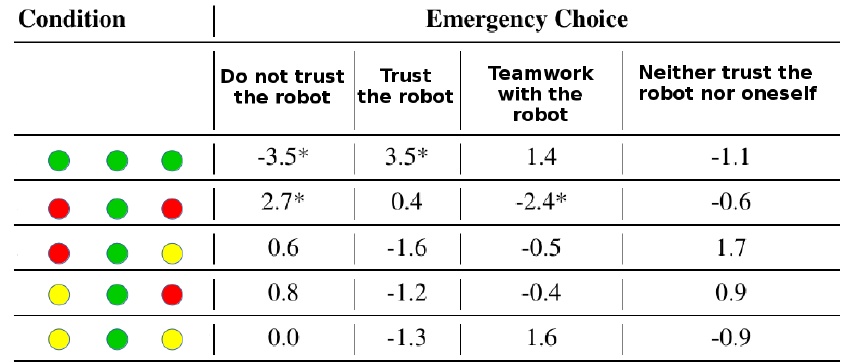
Figure 5: The adjusted standardised residuals of the Crosstabulation between the choices made by the participants in the emergency sce- nario and the different conditions presented to the